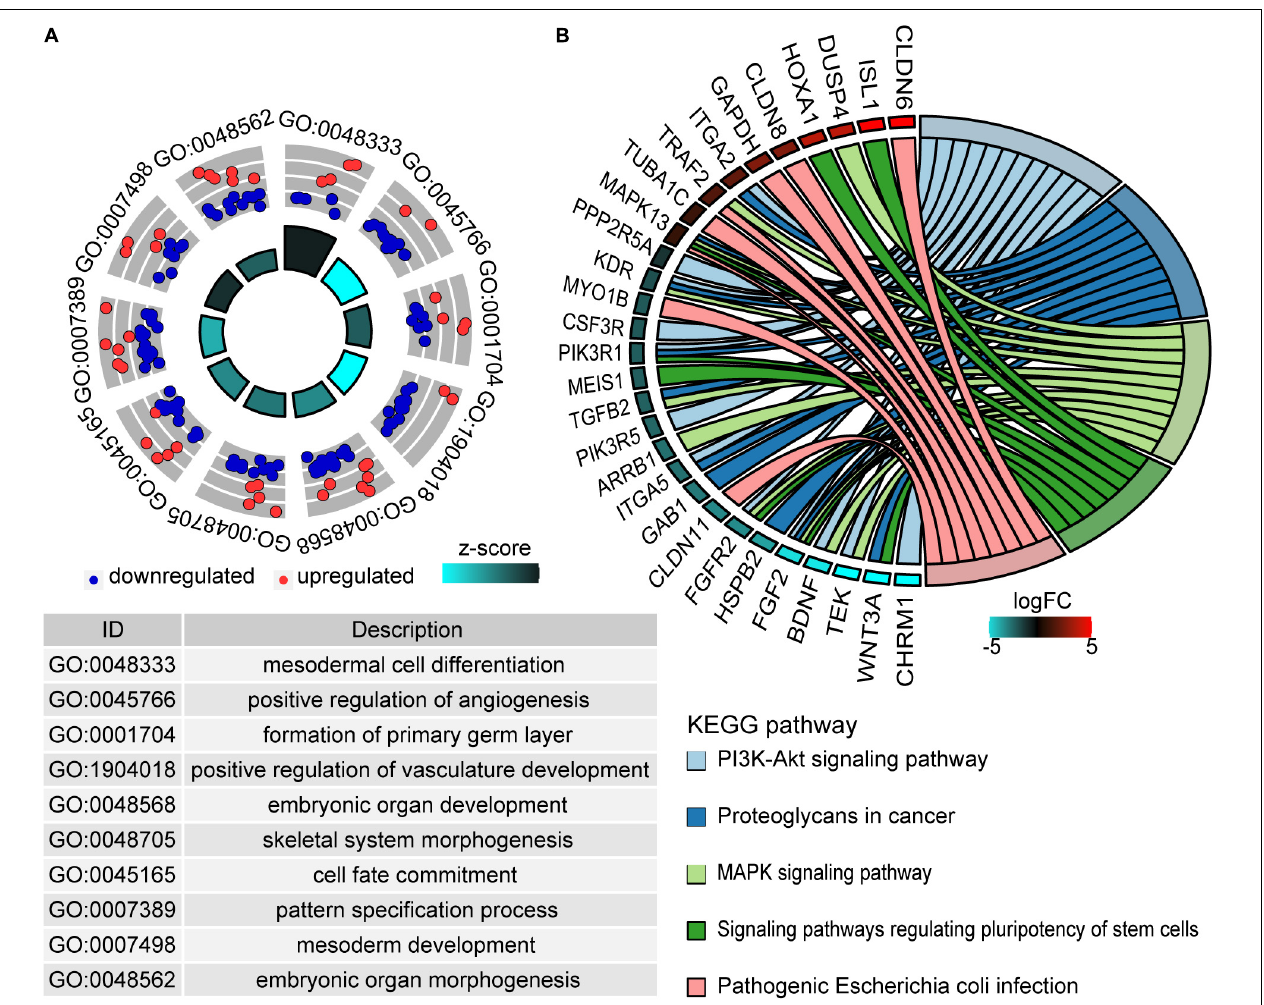
FIGURE 3 | Functional enrichment analysis of methylation driver genes. (A) The top 10 enriched terms of the biological process of GO. The outer circle represents the expression values (log2FC) of methylation driver genes in each enriched GO term. Red dots imply upregulated genes and blue dots imply downregulated genes. The inner circle indicates the significance of GO terms. (B) The chord plot of top five KEGG enriched pathways. The left outer semicircle represents the log2FC value of methylation driver genes, and the right semicircle corresponds to five pathway entries.